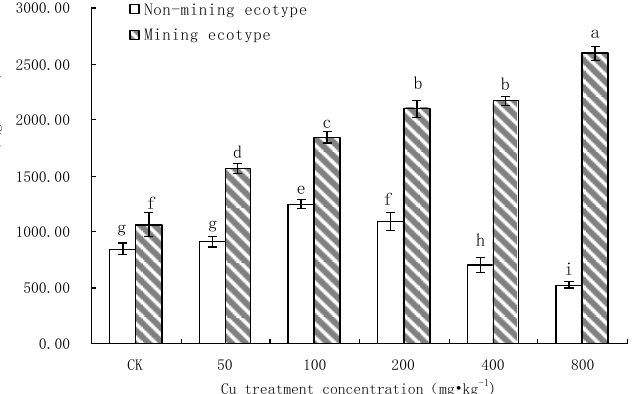
Figure 6. Activity of SOD of two ecotypes of M. floridulus under different Cu treatment. Note: Error bars indicate standard deviation; Different letters in the same group indicate significant difference at p < 0.05 according to Duncan’s multiple range tests; the same below.